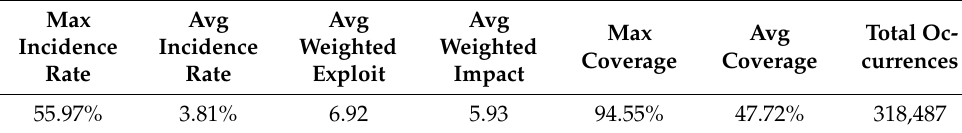
Table 8. Data factors of “Broken Access Control” in OWASP Top